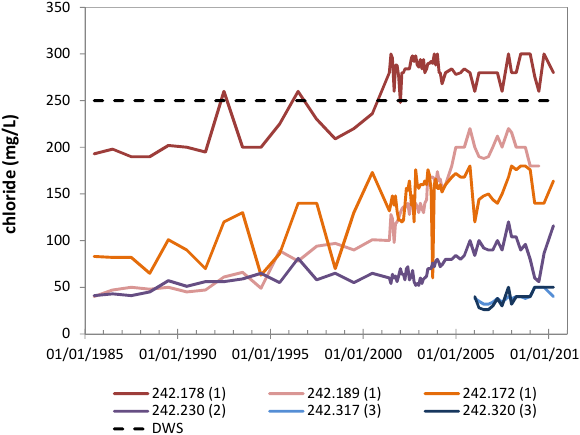
Fig. 4. The development of chloride concentrations in water sup- ply wells. The chloride concentrations have been analyzed approx- imately once a year since 1985. Selected examples from all three well fields (Fig. 6) are shown. DWS: The EU/WHO drinking water standard for chloride (=250mgL − 1